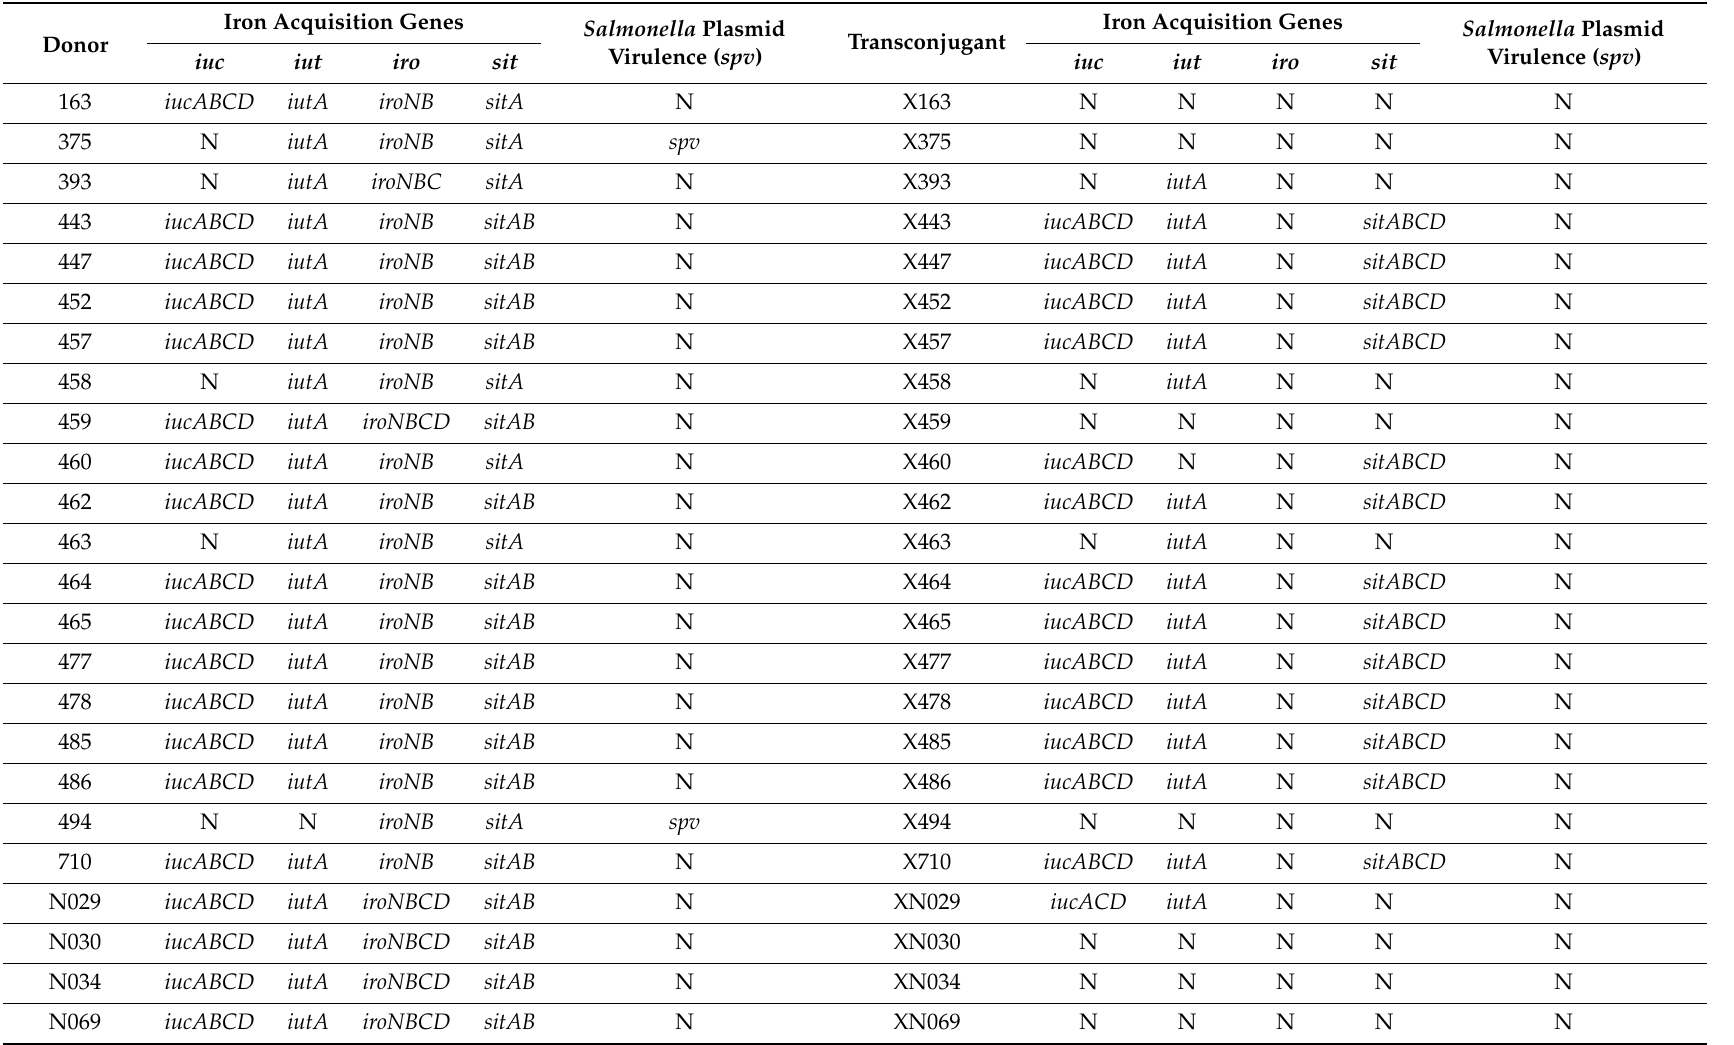
Table 4. In silico genome analysis for isolates that were able to transfer virulence genes to recipients and generate